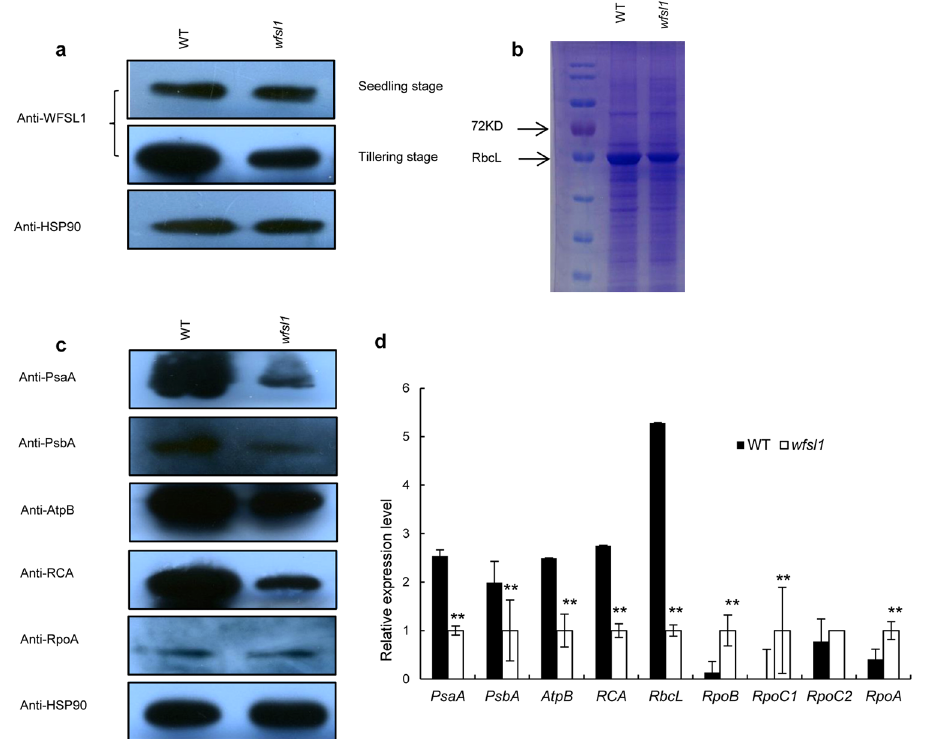
Figure 7. Protein levels analysis of WFSL1 and some representative proteins. ( a ) Western blot analysis of wild type and wfsl1 at seedling and tillering stage. ( b ) SDS-PAGE gel shows Rubisco using Coomassie Brilliant Blue stained in wild type and wfsl1 at tillering stage. ( c ) Western blot analysis of chloroplast proteins and RCA. ( d ) qRT-PCR analysis the relative expression level of plastic encoding genes in wild type and wfsl1 at tilering stage. Hsp90 was used as an internal control. Error bars represent the SD from three independent experiments (Student’s t -test, * P < 0.05; ** P <